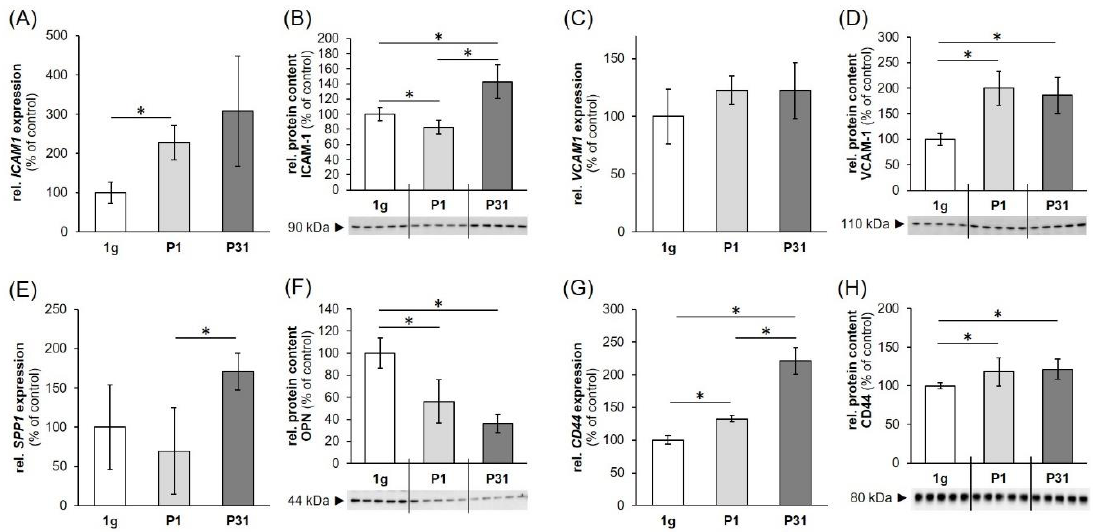
Figure 6. Expression of genes: ( A ) ICAM1 , ( C ) VCAM1 , ( E ) SPP1 , ( G ) CD44 ; and proteins: ( B ) ICAM-1, ( D ) VCAM-1, ( F ) OPN, ( H ) CD44 involved in cell adhesion. 1 g: ground control; P1: parabola 1; P31: parabola 31. The data are given as mean ± standard deviation. * p < 0.05 vs. 1 g -control; ** p < 0.01 vs. 1 g -control.